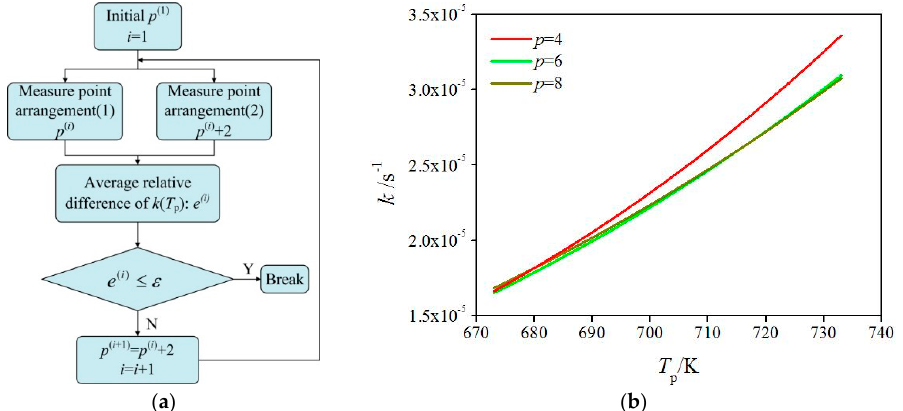
Figure 8. Measure-point-independence verification. ( a ) flowchart of measure-point-independence verification, ( b ) comparisons of Arrhenius equations obtained at four, six, and eight measure points.